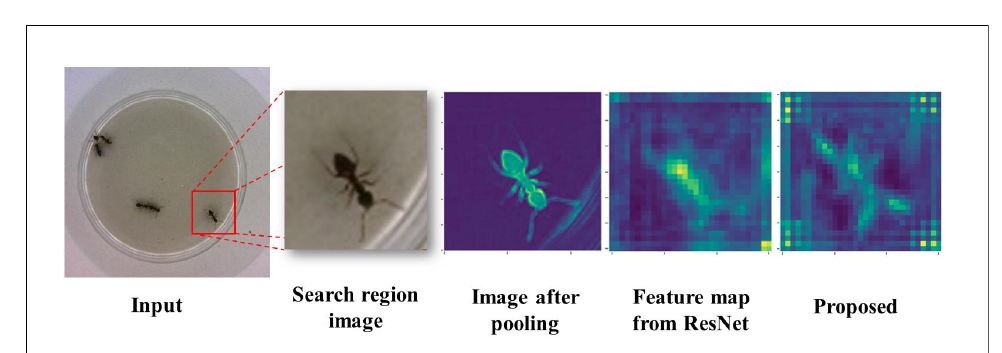
Figure 5. Feature extraction comparison